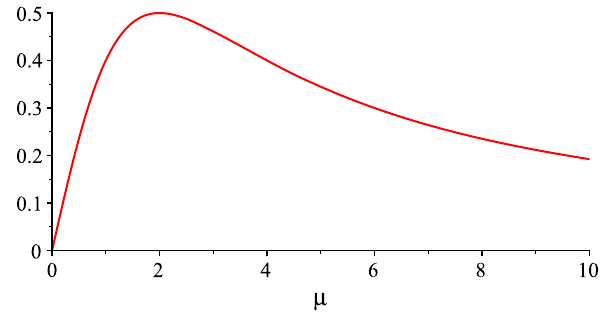
Fig. 3 The dimensionless numerical factor 2 μ/( 4 + μ 2 ) (vertical axis) as a function of μ (horizontal